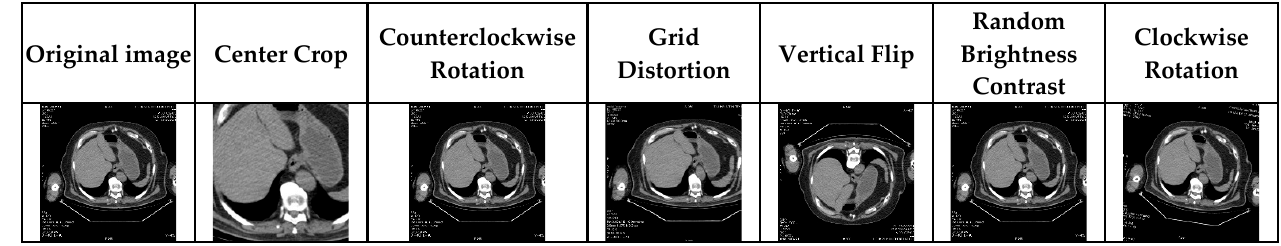
Figure 4. Outputs of images obtained by data augmentation method.